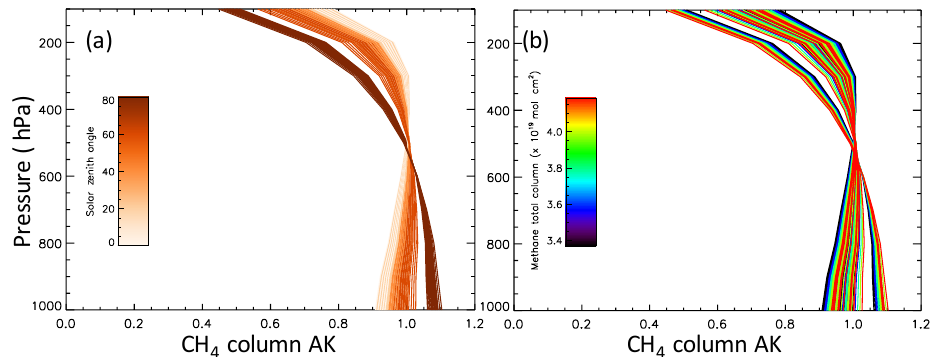
Figure 16. Variation of CHRONOS CH 4 averaging kernels for different SZA (a) and CH 4 total column (b) for 100 simulations with different SZA and CH 4 column values. Within each “group” of SZA values, the lesser AK dependence on low-to-high values of CH 4 can be